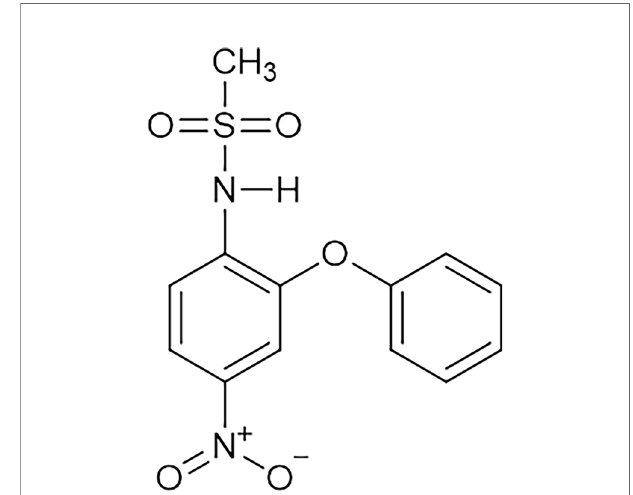
FIGURE 4 | Molecular structure of nimesulide. Nimesulide (N-(4-nitro-2- phenoxyphenyl)-methanesulfonamide) is a non-steroidal anti-in fl ammatory (NSAID), which contains a methylsulfonamide portion in its structure and is a weak acid. It has an acidity constant ranging from 6.4 to 6.8, and the melting point occurs between 147°C and 148°C. In addition, it has good solubility in acetone, chloroform, and ethyl acetate, with relative solubility in ethanol, and low solubility in water. This fi gure is from: https://pubchem.ncbi.nlm.nih.gov/ compound/Nimesulide (accessed on Mar. 14,